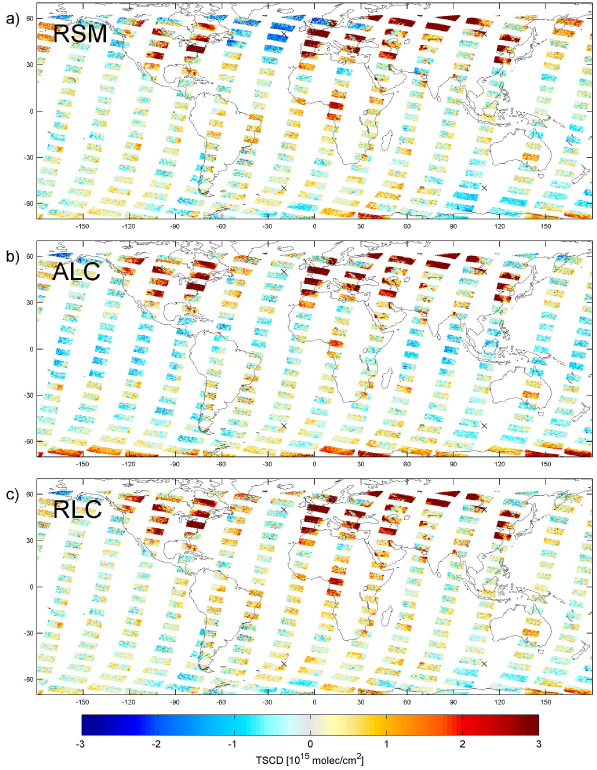
Fig. 5. Stratospheric VCDs W on 28 January 2006 for the different stratospheric estimation schemes: (a) reference sector method, (b) absolute limb correction, and (c) relative limb correction.